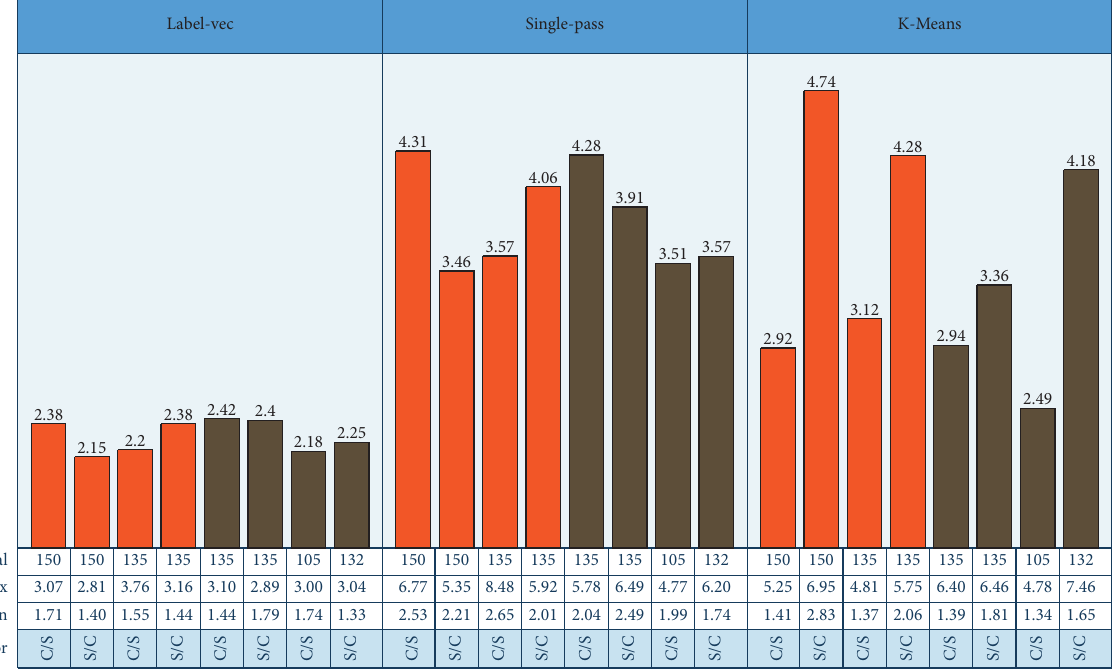
Figure 5: Comparison of the time-consuming duration of the algorithm.